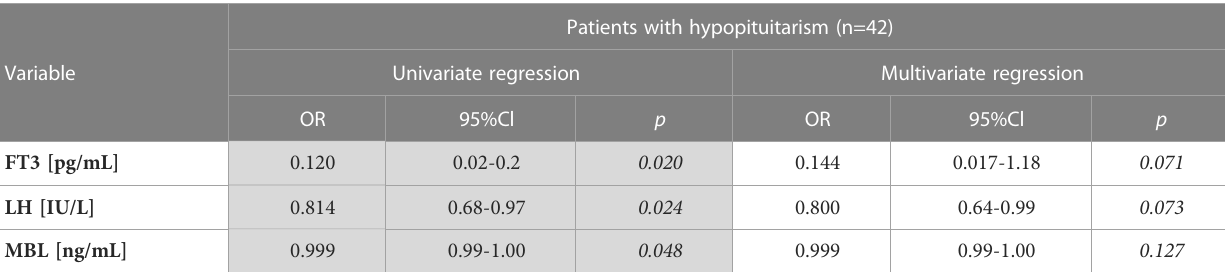
TABLE 6 Univariate logistic regression analysis of non-compensated hypopituitarism (inadequate hormone replacement therapies) determinants (linear variables) performed in patients with hypopituitarism (n=42).